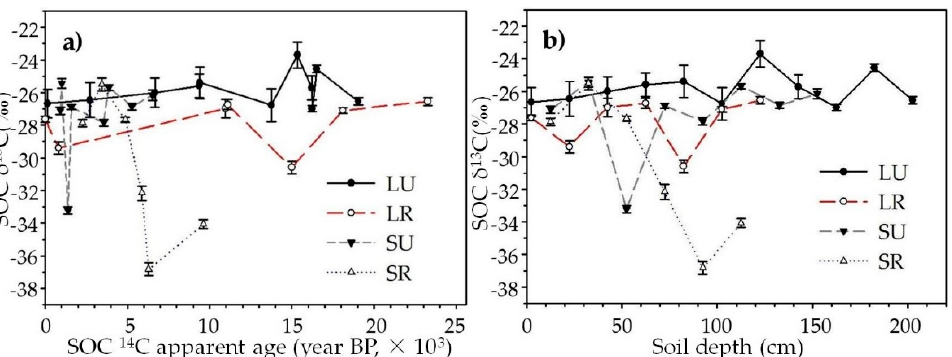
Figure 9. Temporal ( a ) and spatial ( b ) distributions of soil organic carbon (SOC) δ 13 C values with SOC 14 C apparent age and soil depth in the four soil profiles (LU, LR, SU and SR) in a montane subtropical moist forest of southwestern China. Error bars indicate analytical precision of two standard deviations.